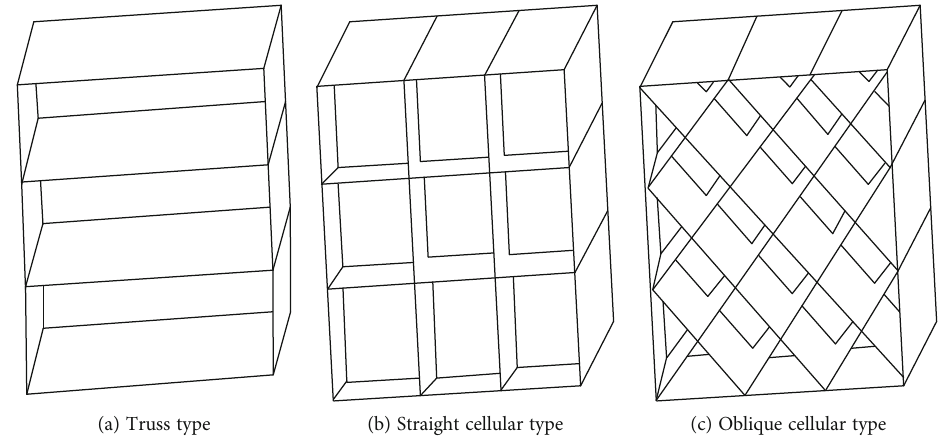
Figure 1: Schematic diagram of grid wing with di ff erent structural